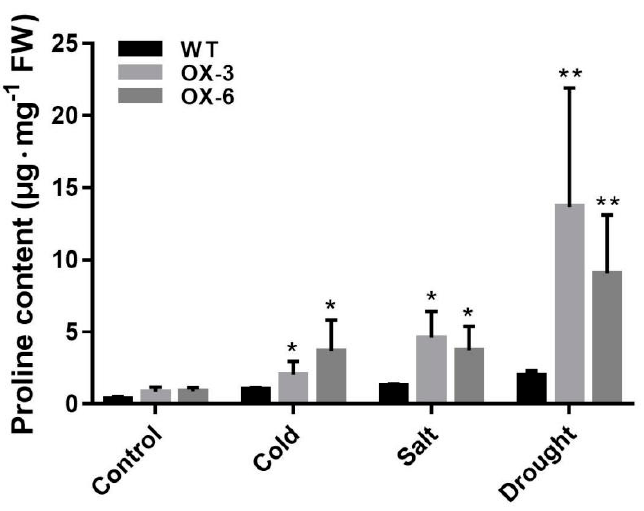
Figure 8. The proline content in 35S::FaNAC2 lines and WT leaves under different abiotic stress treatments. The fifth leaf was collected for proline content determination. Bars are means (±S.D.) of three independent experiments (Student’s t -test; * p < 0.05; ** p < 0.01).